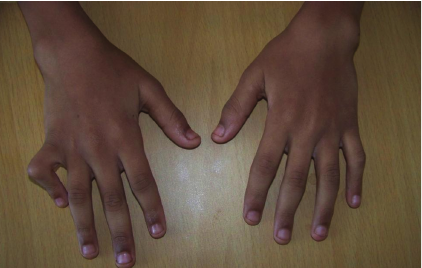
Figure 1: Photograph of hand showing camptodactyly-curved little finger.